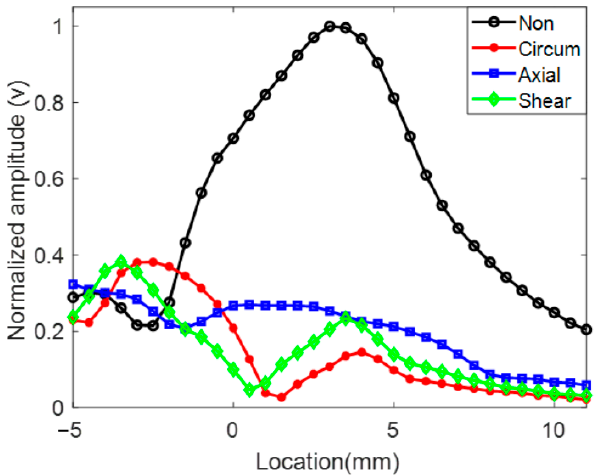
Figure 13. Experiment result of amplitude profiles with the same crack size (700 μ m).